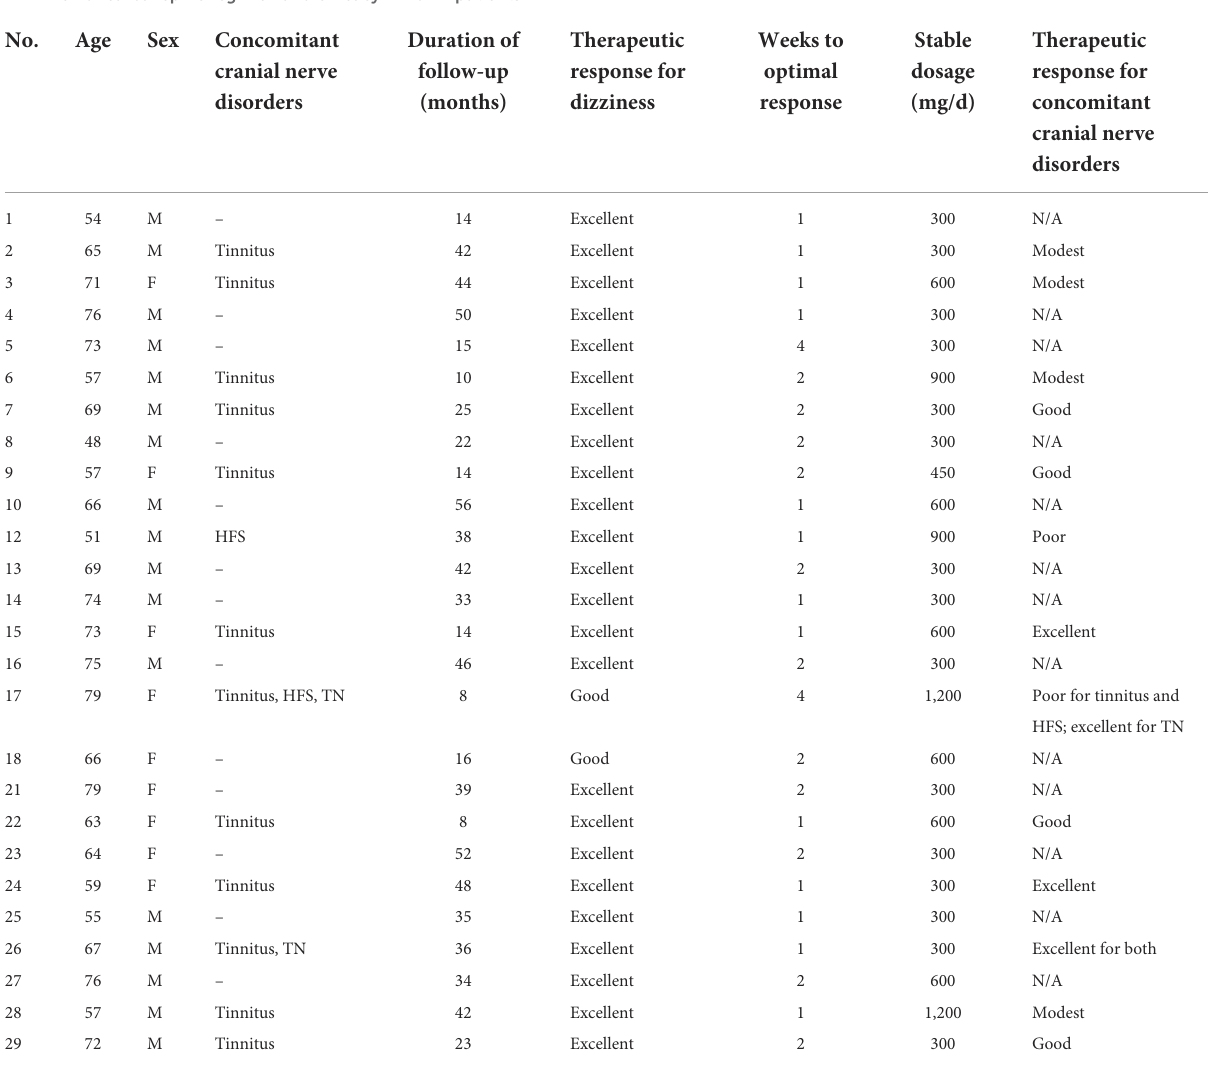
TABLE 3 Oxcarbazepine regimen and efficacy in 26 VP